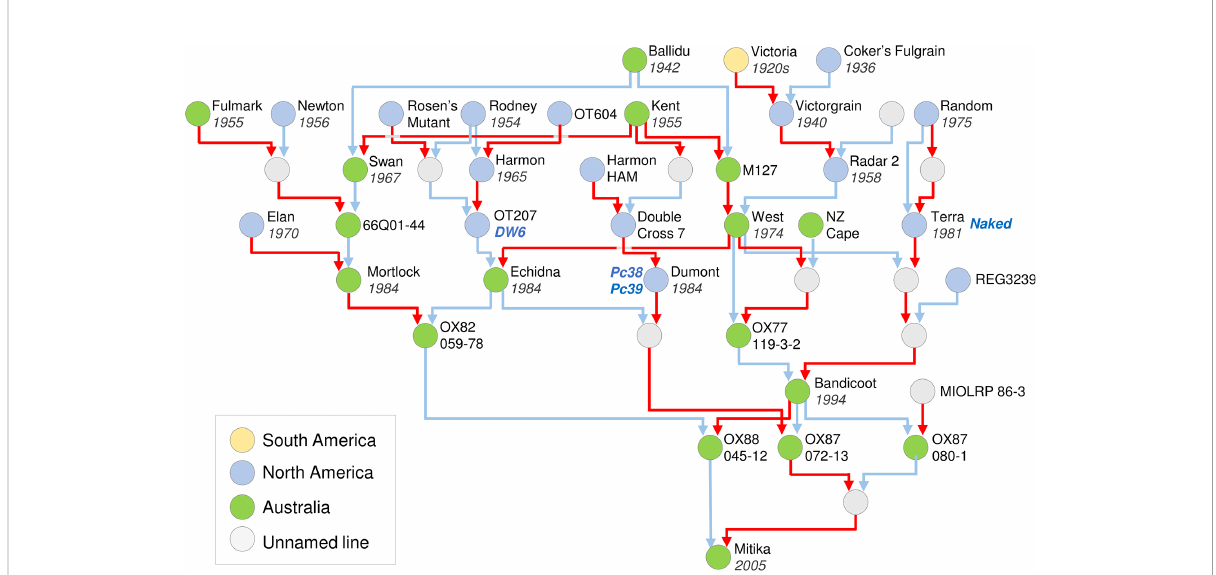
FIGURE 3 Pedigree of an elite Australian spring oat cultivar, cv. Mitika. A simpli fi ed pedigree of cultivar Mitika, modi fi ed from a Helium output (Shaw et al., 2014) generated from the pedigrees of over 1000 international accessions spanning diversity relevant to the history of Australian oat breeding. Pedigrees are shown as far back as early 20 th century oats from Australian and North America. For ease of representation, multiple rounds of backcrossing are not shown. Pedigrees were obtained from the “ Pedigrees of Oat Lines ” POOL database (Tinker and Deyl, 2005), from Fitzsimmons et al. (1983) and directly from oat breeders (Dr Pamela Zwer and Dr Bruce Winter, personal communication). The year of release is indicated for cultivars. Red line indicates maternal parent connection and blue indicates paternal parent (pollen donor). Colours of circles indicate region of origin for released lines. Grey circles indicate unnamed intermediate lines used in